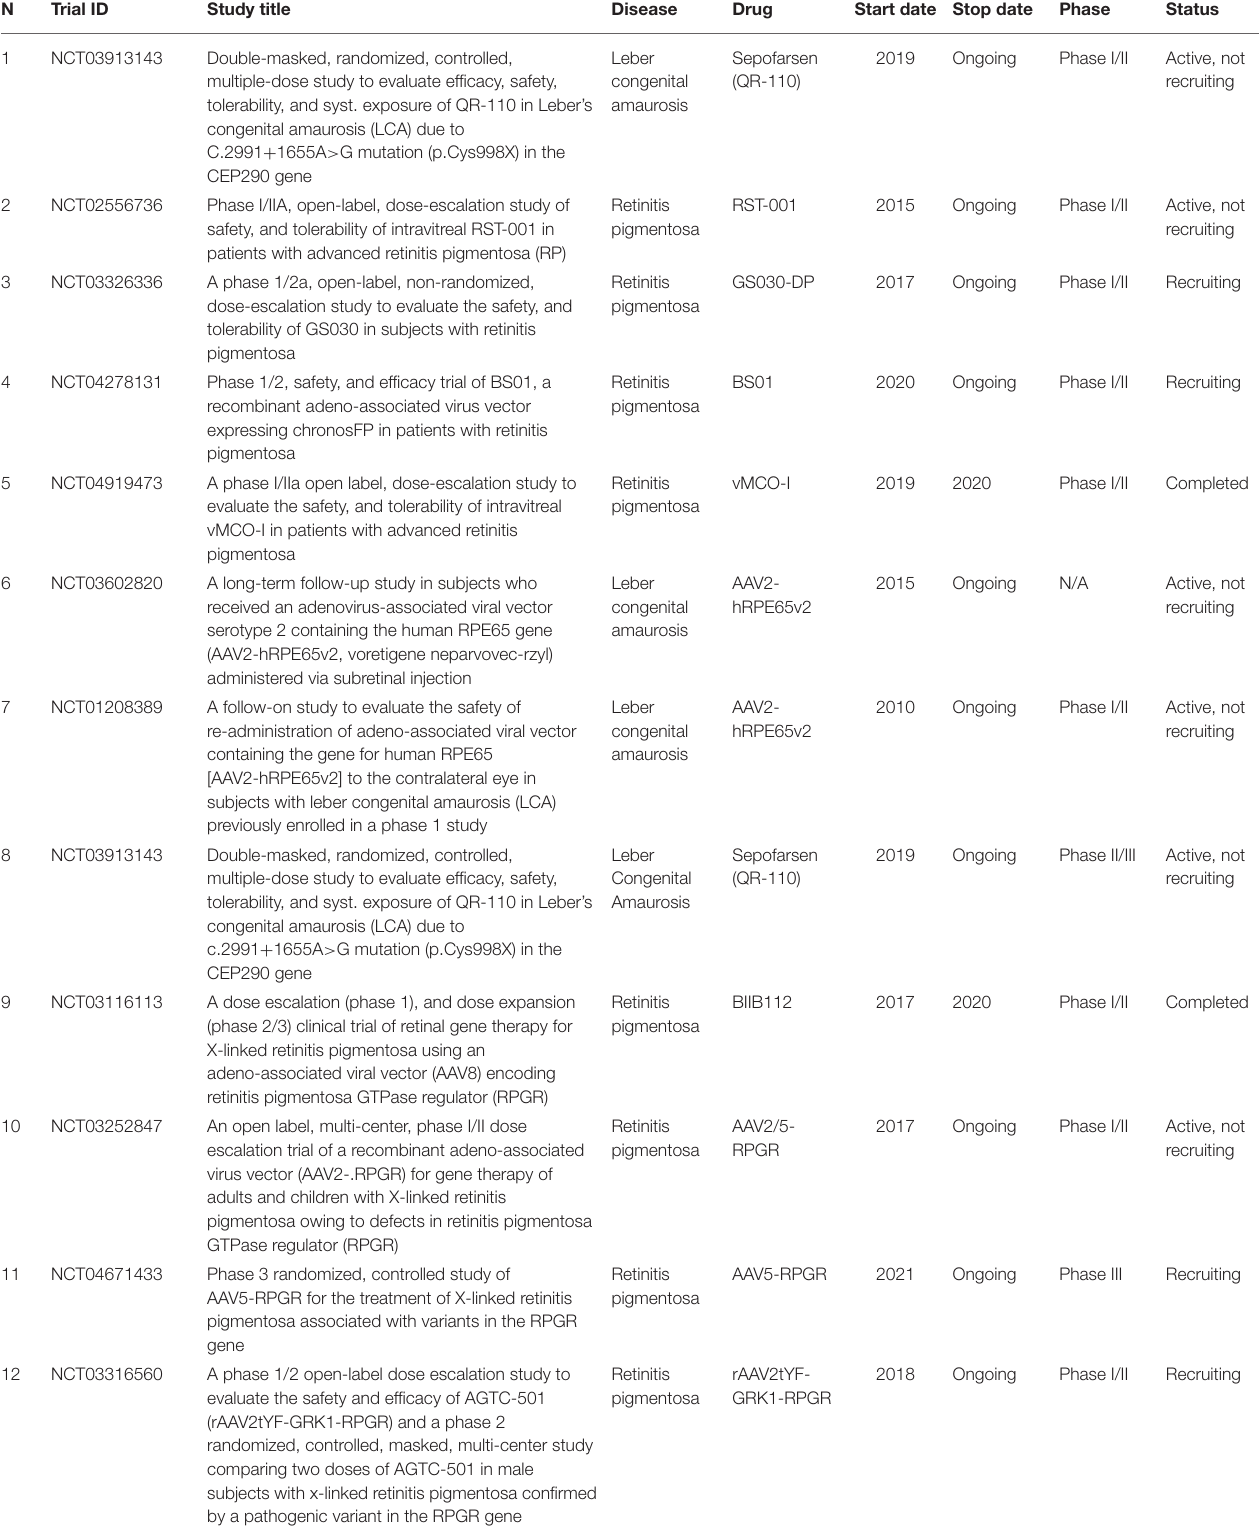
TABLE 2 | Clinical trials on